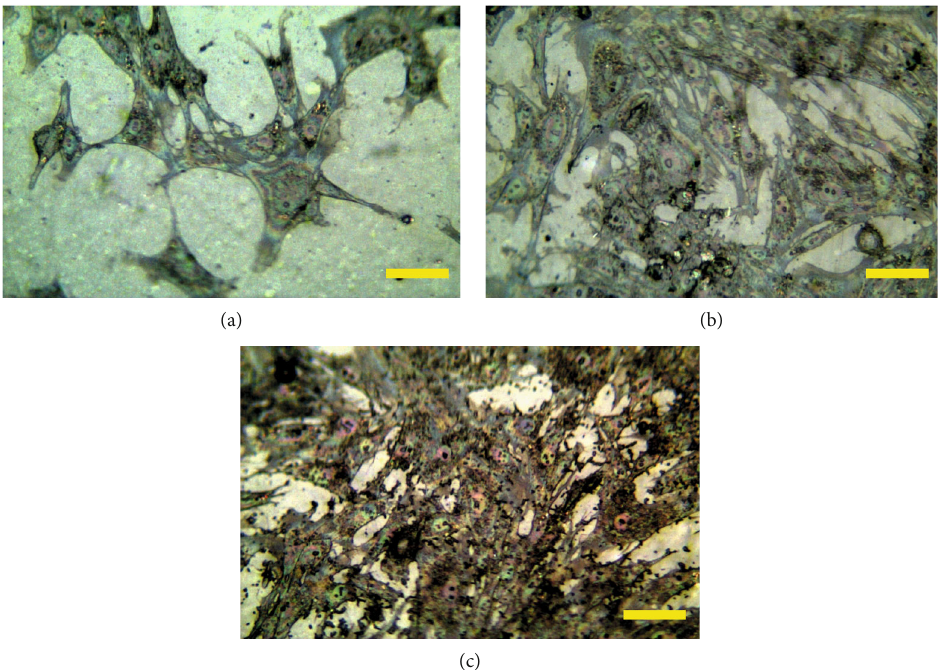
Figure 7: Images of fi broblast cells grown for 48h on (a) PET untreated fi lm, (b) PET-3Au, and (c) PET-5Au (scale 100 μ m). Table 3: Results of “ in vitro ” antimicrobial activity testing of compounds and inhibition zones (mm) after 24 hours. Fungi Sample